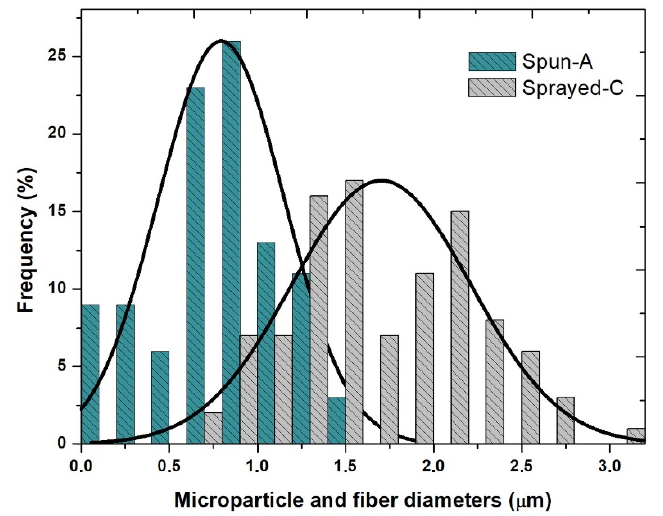
Figure 4. Histogram of size distribution of the PVP-copper salt composite fibers (spun A) and PVP-copper salt composite microparticles (sprayed C).